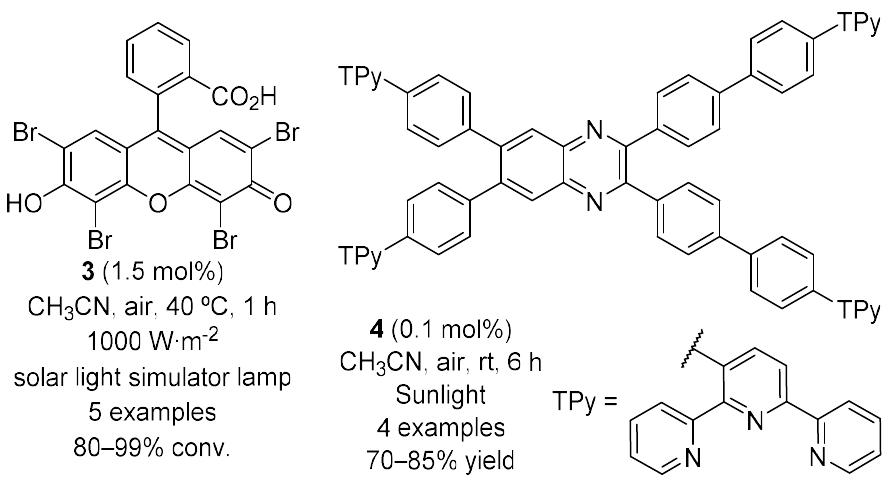
Figure 1. Results obtained in the aerobic photo-oxidative coupling of benzylamines to render N - benzylidene benzylamines 2 catalyzed by 3 and 4 .